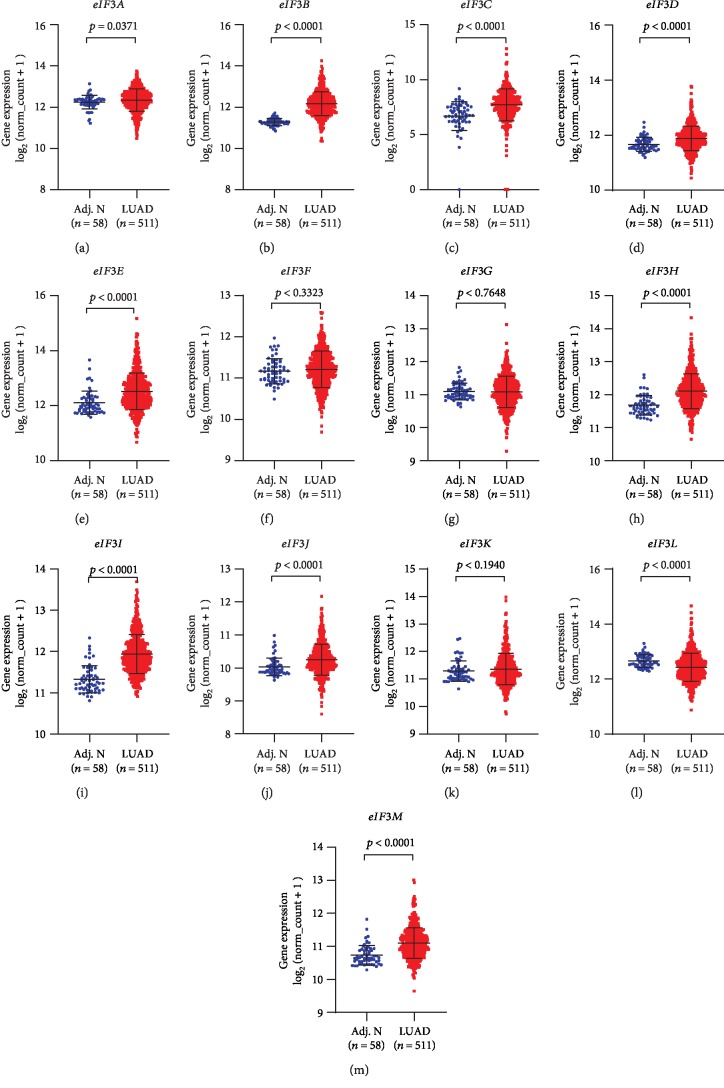
Plot charts showing mRNA expression of eIF3 subunits in LUAD tissues and adjacent normal tissues. Adj. N: adjacent normal tissues.